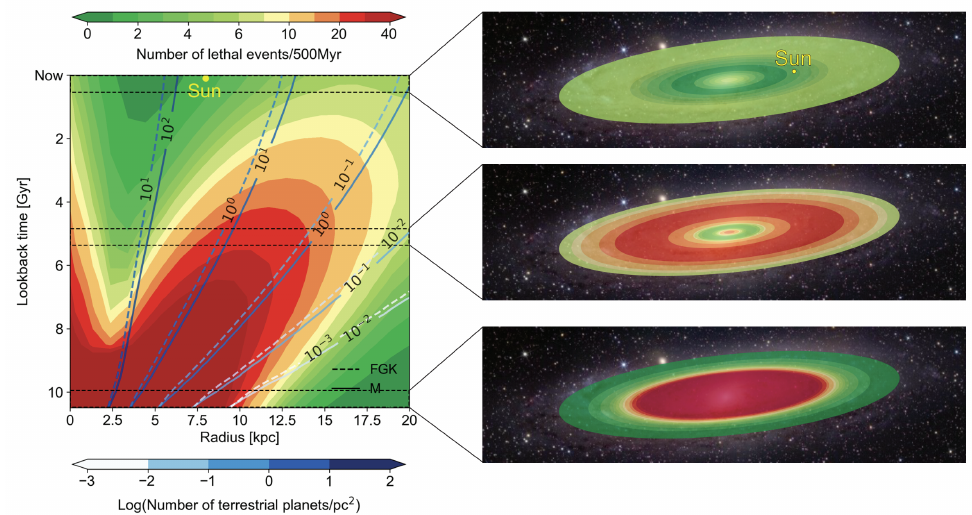
Figure 7. Number of lethal events (combining GRBs, both long and short, and SNe) as a function of the galactocentrinc radius and lookback time ( left panel ). The shaded contours (referred to as the color bar on top of the plot) show the number of lethal events per bin of 0.5 Gyrs. The line contours (corresponding to the color bar at the bottom of the plot) show the surface number density of terrestrial planets around M stars (solid lines) and FGK stars (dashed lines). The current position of the solar system is marked by the yellow dot. The three right panels are artistic representations of the galaxy habitability in three representative epochs with a similar color cording for the upper bar (i.e., representing the number of lethal